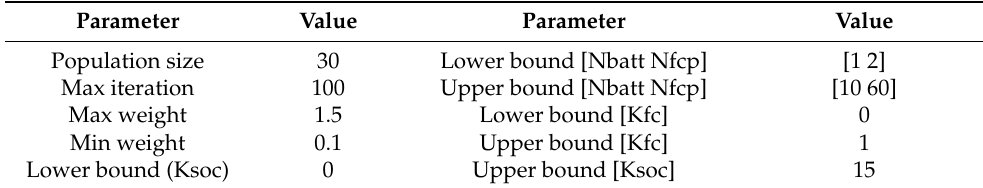
Table 5. PSO algorithm parameters and